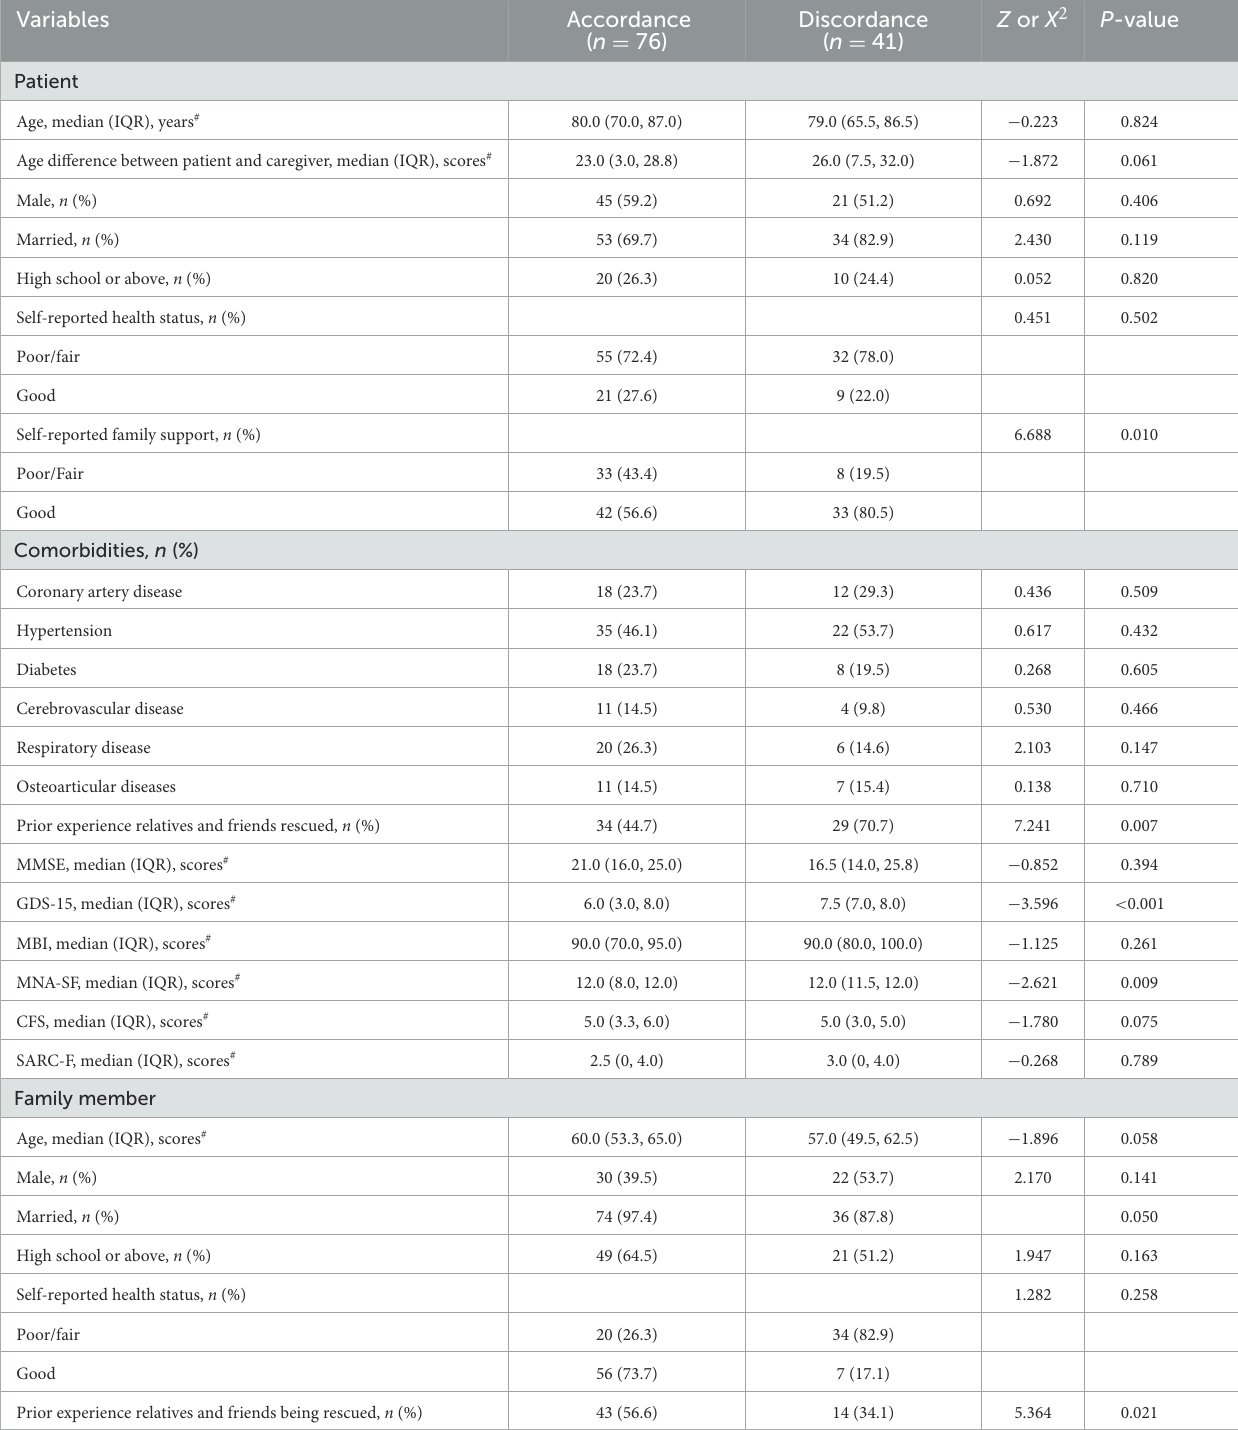
TABLE 3 The patient and family member factors associated with discordance attitudes toward ACP by bivariate analysis. Variables Accordance